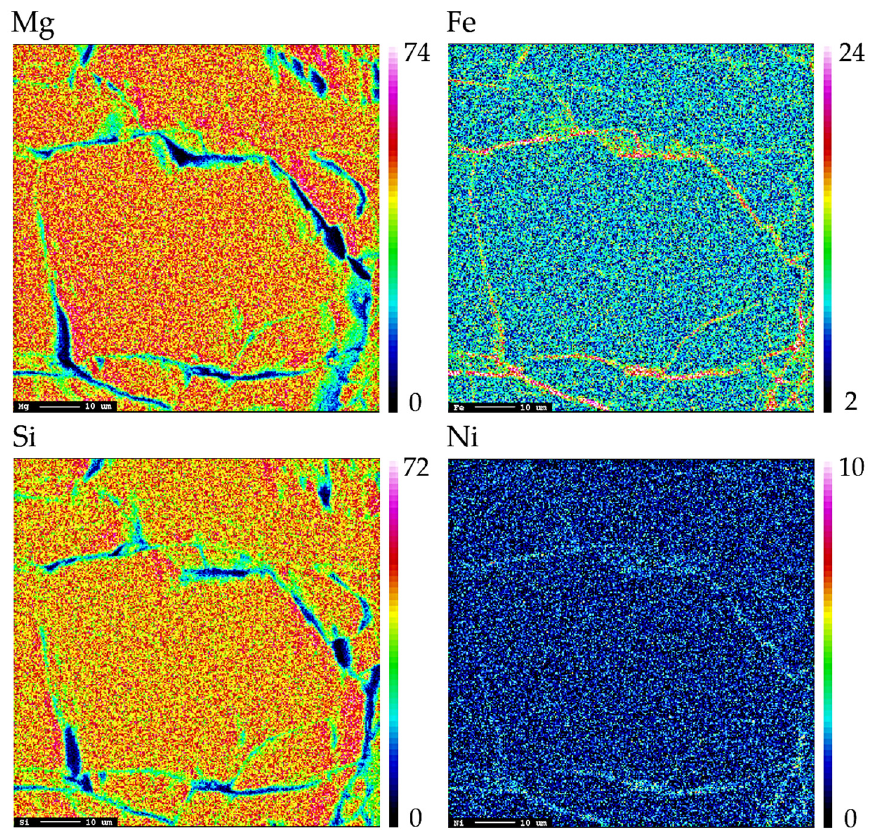
Figure 4. Quantitative EPMA distribution maps of Mg, Fe, Si, Ni in a selected olivine crystal within the Mineo pallasite. The color-scale is relative to the counts of each element.